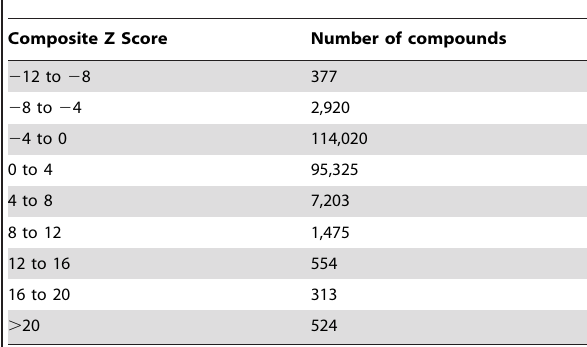
Table 2. Summary of the HTS data.